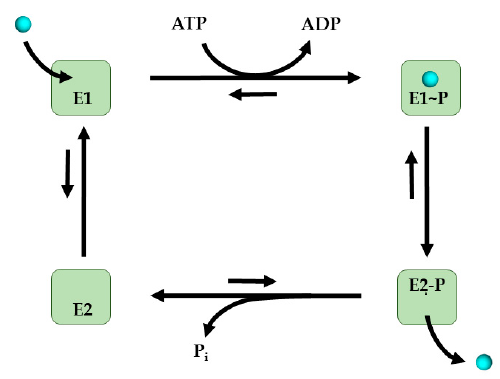
Figure 8. The Post-Albers cycle of P-type ATPases. For details, see text. Cu is shown as cyan sphere.